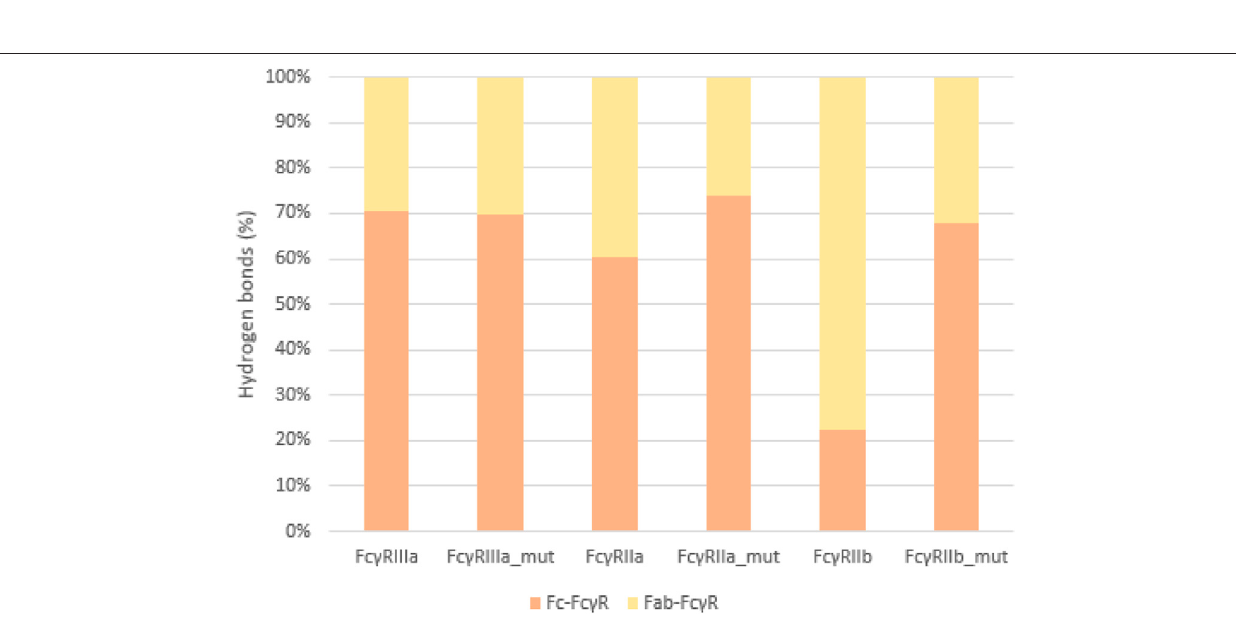
Frontiers in Chemistry |